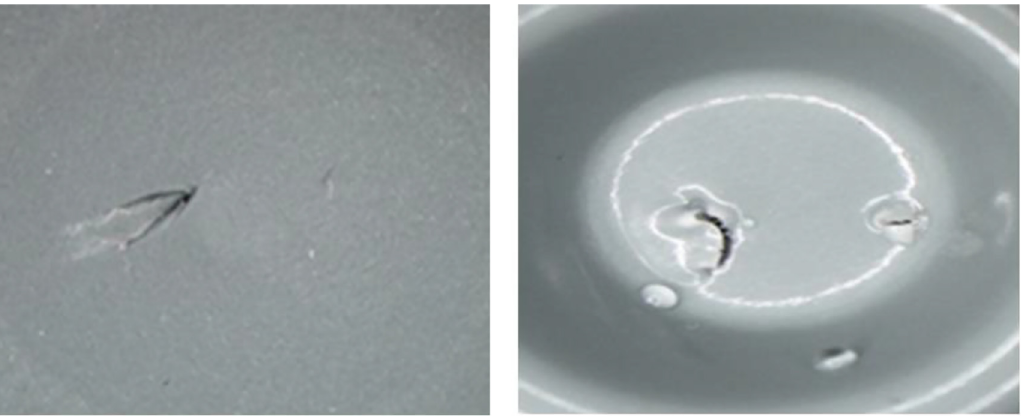
Figure6: Tearingonstopperspenetratedusingmethod2withthebeveldown(imagesviewedunder10 × eyepiecelens,1 × objectivelens,and zoomed 8 × for a total magni fi cation of 80 ×